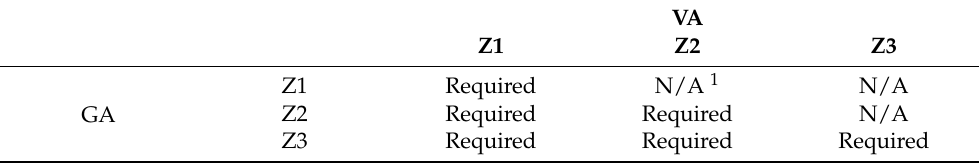
Table 2. Interoperability requirements of various Z